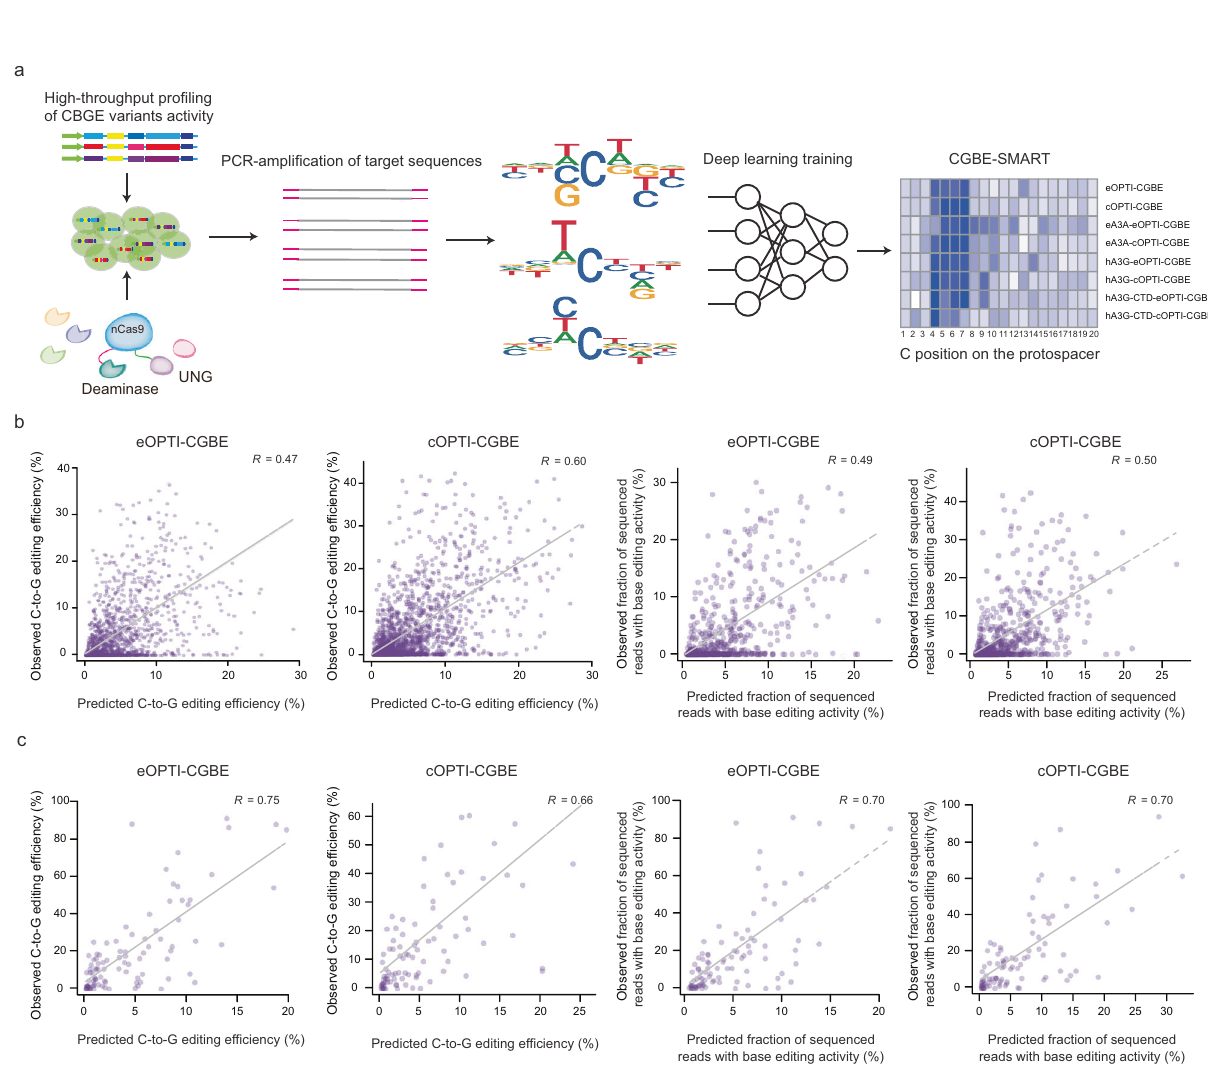
Fig. 3 Machine-learning models of OPTI-CGBEs. a Model design for predicting C-to-G base editing ef fi ciency. b Comparison of predicted versus observed base editing ef fi ciency or faction of sequenced reads with base editing activities at target sites of OPTI-CGBEs using lentiviral paired sgRNA library. c Comparison of predicted versus observed base editing ef fi ciency or faction of sequenced reads with base editing activities at 80 endogenous target sites of OPTI-CGBEs. R values demonstrated Pearson ’ s correlation coef fi cients. CGBE-SMART can be trained on different observed data and corresponding studies 26,27 (see Methods). We found that CGBE- predict editing outcome for novel inputs, we next applied our SMART achieved high prediction accuracy in C-to-T editing model to predict C-to-T editing ef fi ciency and compared with BE- ef fi ciency for all the four datasets (averaged R = 0.75; Supplemen- Hive and DeepCBE using the test datasets from the two tary Fig. 9e). In comparison with BE-Hive, CGBE-SMART NATURE COMMUNICATIONS| (2021) 12:4902